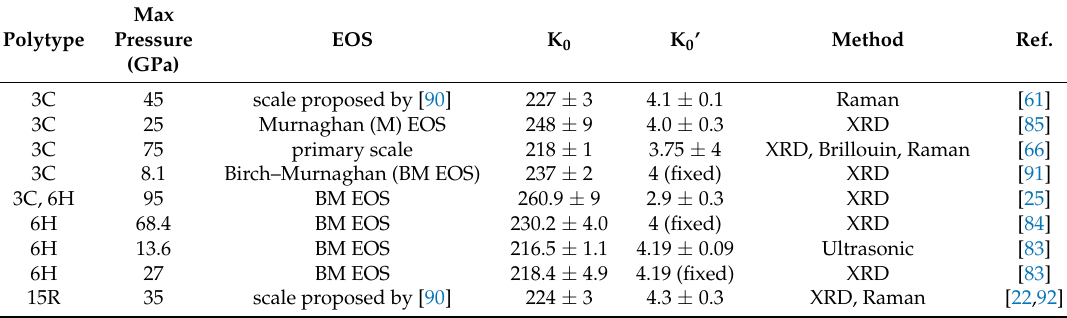
Table 2. Experimental equations of state for several polytypes of